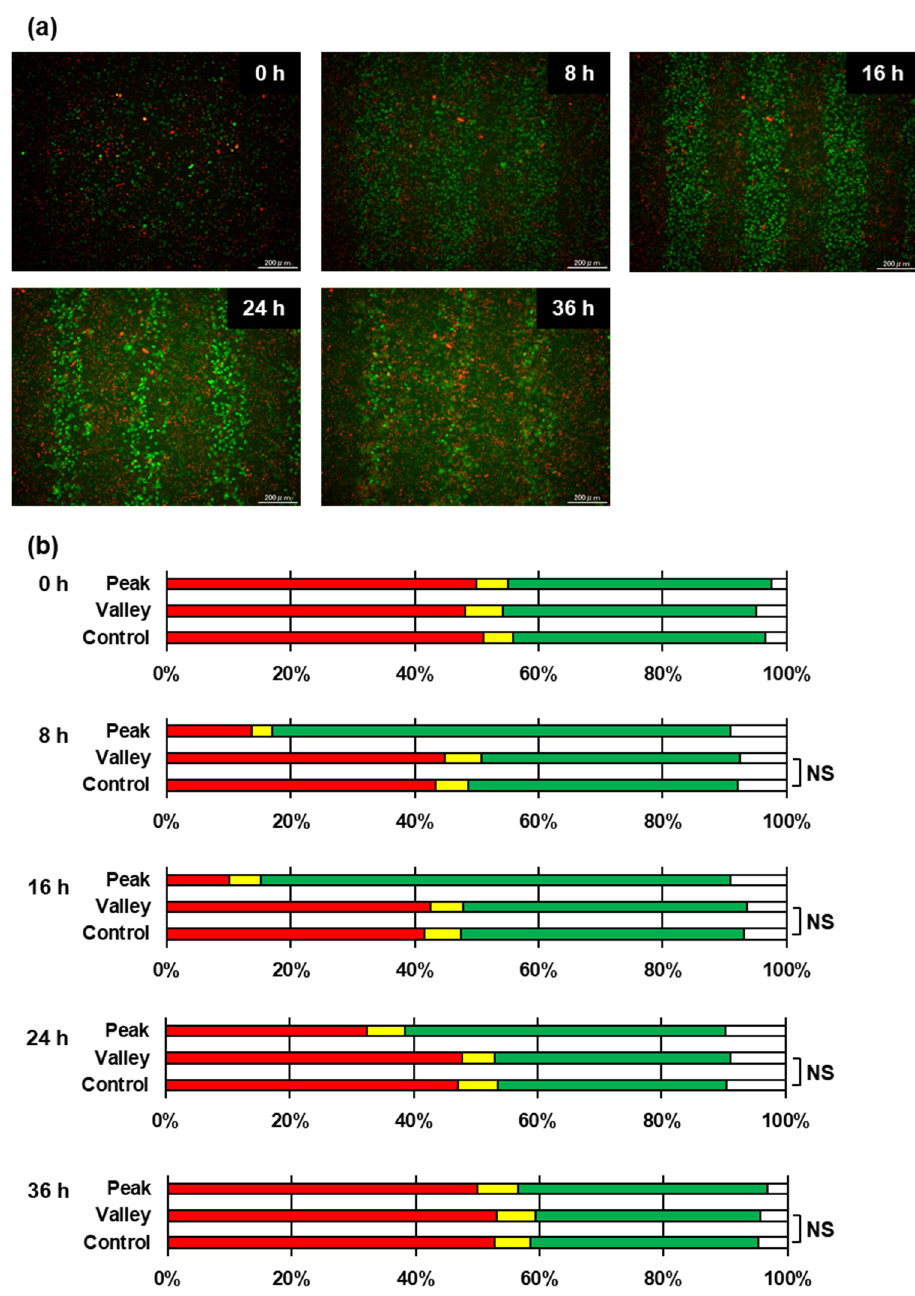
Figure 4. Time-lapse imaging of HeLa–FUCCI cells following exposure to 200 µ m-slit X-ray beams. ( a ) Representative fluorescent images of HeLa–FUCCI cells 0, 12, 24, and 48 h following exposure to the 200 μ m-wide microbeams (refer to Figure 1). Cell nuclei are indicated by the red, yellow, green, and colorless regions depending on their cell cycles: G1, G1/S, S/G2, and M, respectively. Scale bar, 200 μ m. ( b ) Summary graph of fluorescent color distributions in HeLa–FUCCI cells in the control, valley, and peak regions. The color of the bars indicates the color of the cells, respectively. There was no difference in the cell-cycle distribution between the control and the valley regions, which suggests that there was no detectable non-targeted effect. NS stands for Non-Significant (chi-square test).